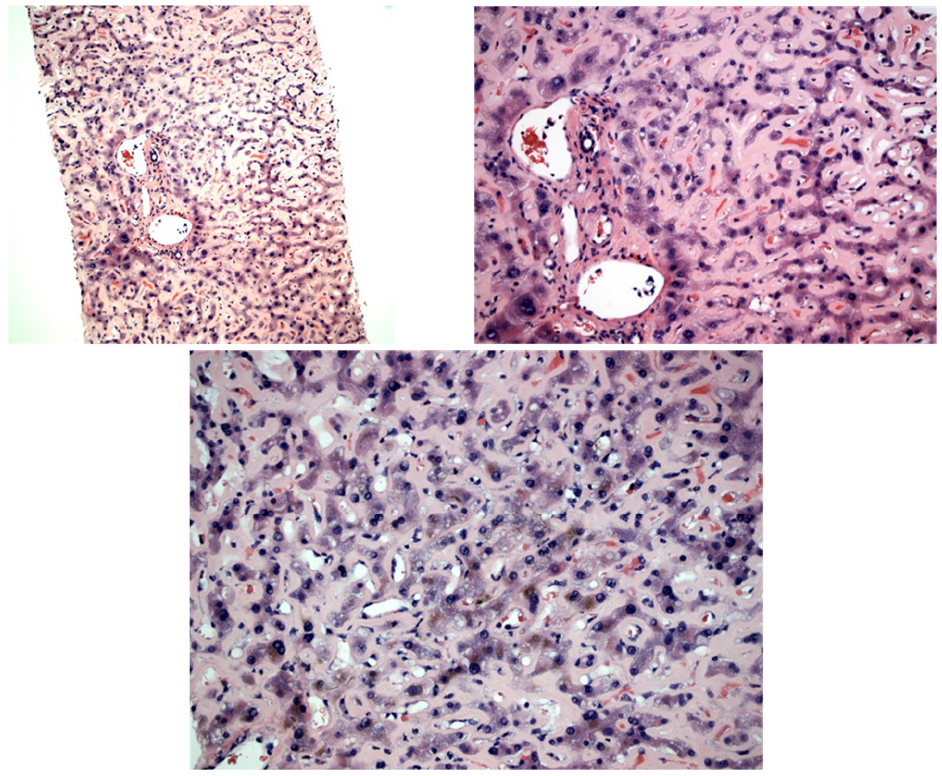
Figure 1. H&E (3A, 100×; 3B and 3C, 200×) shows dense eosinophilic hyaline material expanding the sinusoid throughout the biopsy. Focal yellow bile pigment can be seen, consistent with hepatocel- lular cholestasis. There is no significant portal or lobular inflammation. The eosinophilic hyaline material is negative on Congo red